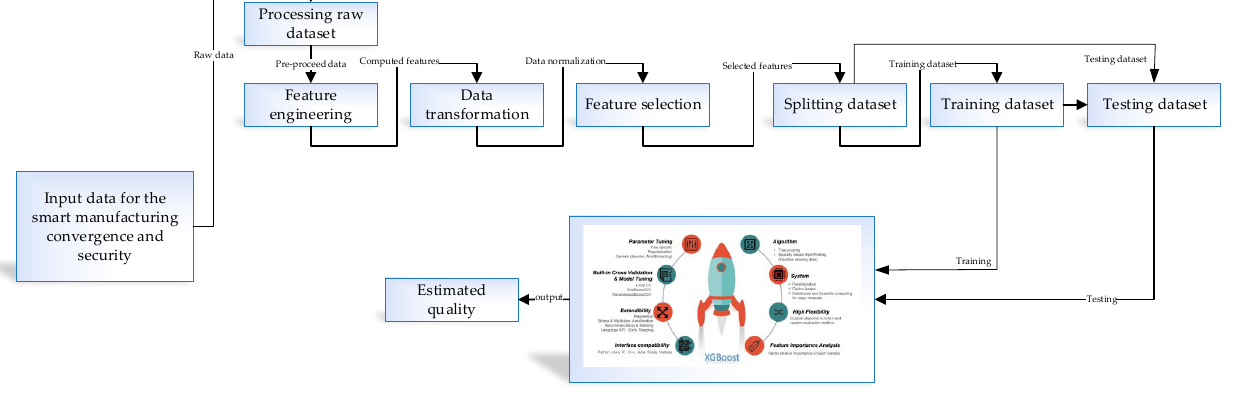
Figure 10. Architectural diagram of the predictive analysis based on